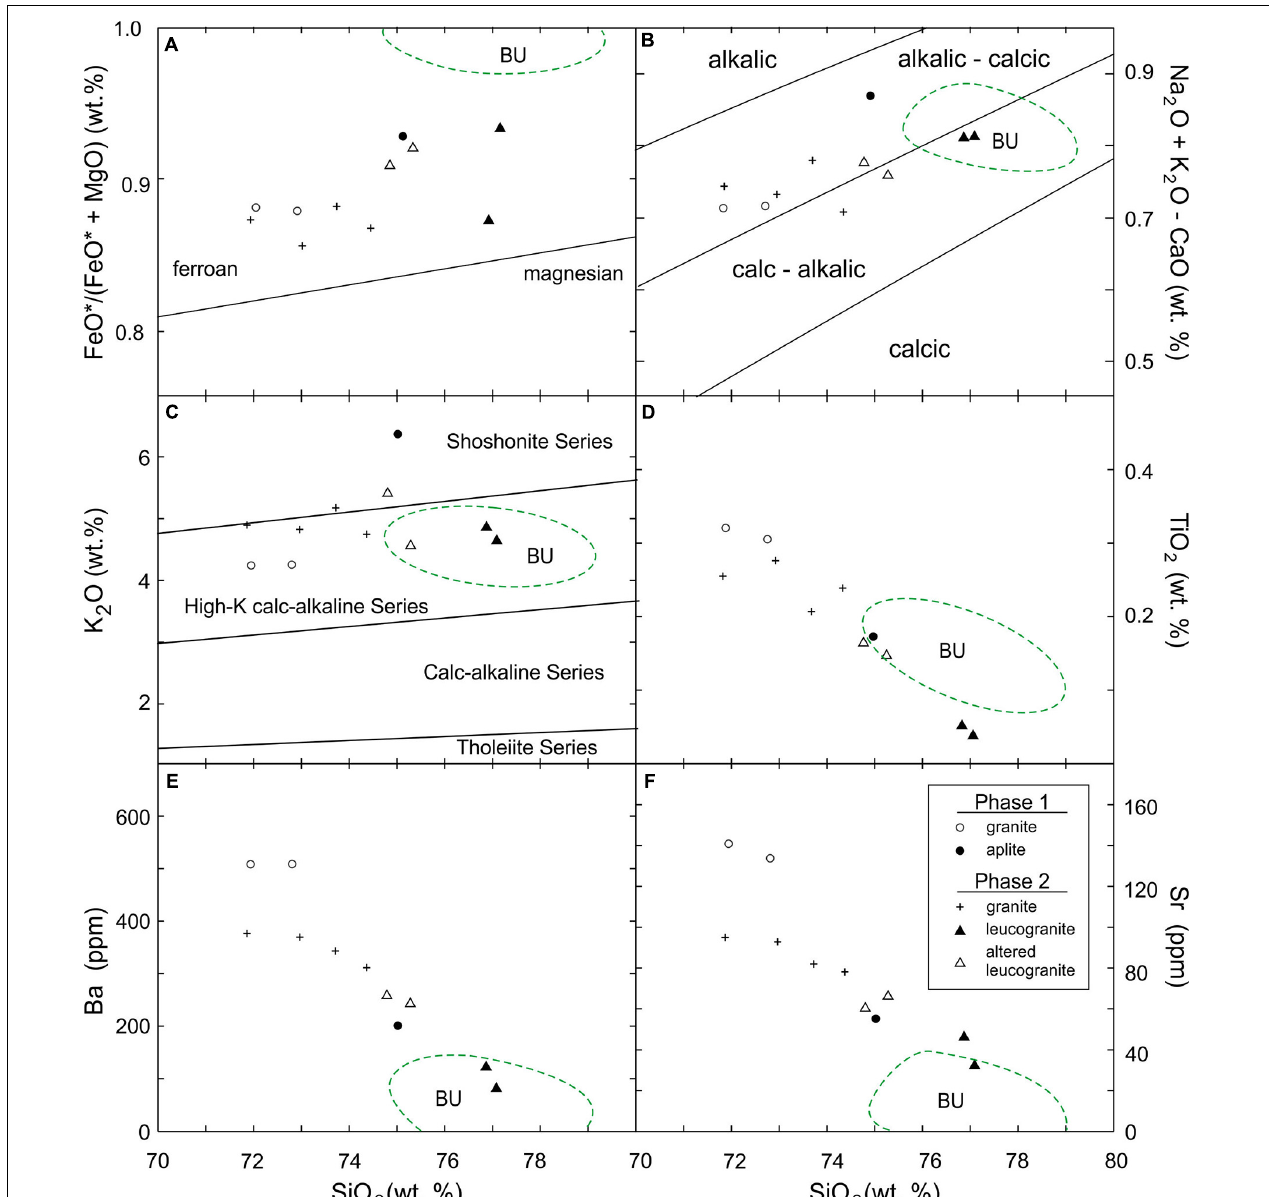
FIGURE 7 | Variations of SiO 2 (wt.%) versus (A) FeO*/(FeO*/MgO) showing the separation of ferroan and magnesian suites based on the relative degree of iron enrichment during differentiation (after Frost and Frost, 2011). (B) Modified alkali-lime index (MALI = Na 2 O + K 2 O-CaO) with fields defined by Frost and Frost (2011). (C) K2O (wt.%) with fields after Peccerillo and Taylor (1976). (D) TiO 2 (wt.%), (E) Ba, and (F) Sr (ppm) in the granitic rocks of the Tukham pluton. Dashed green curves outline the field (BU) for the Bayan-Ulan pluton.